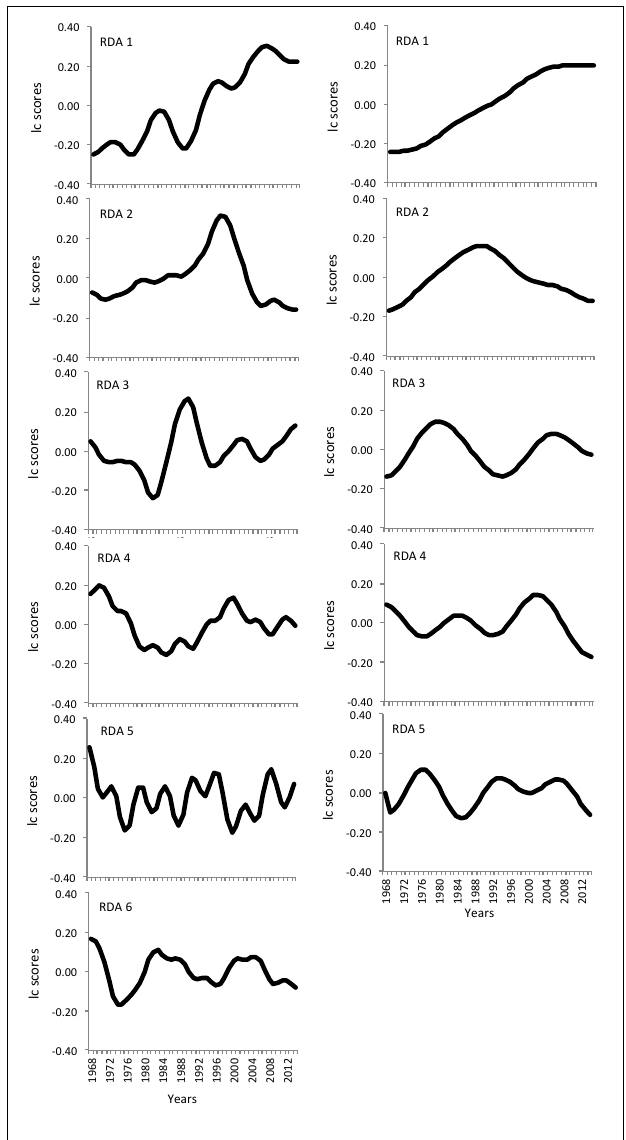
FIGURE 3 | Linear combination (lc) score plots showing significant temporal patterns associated with different RDA axes in the time series models. Panels on the left represent the northern regime that becomes vulnerable to the invasion of the southern regime (right panels) due to climate